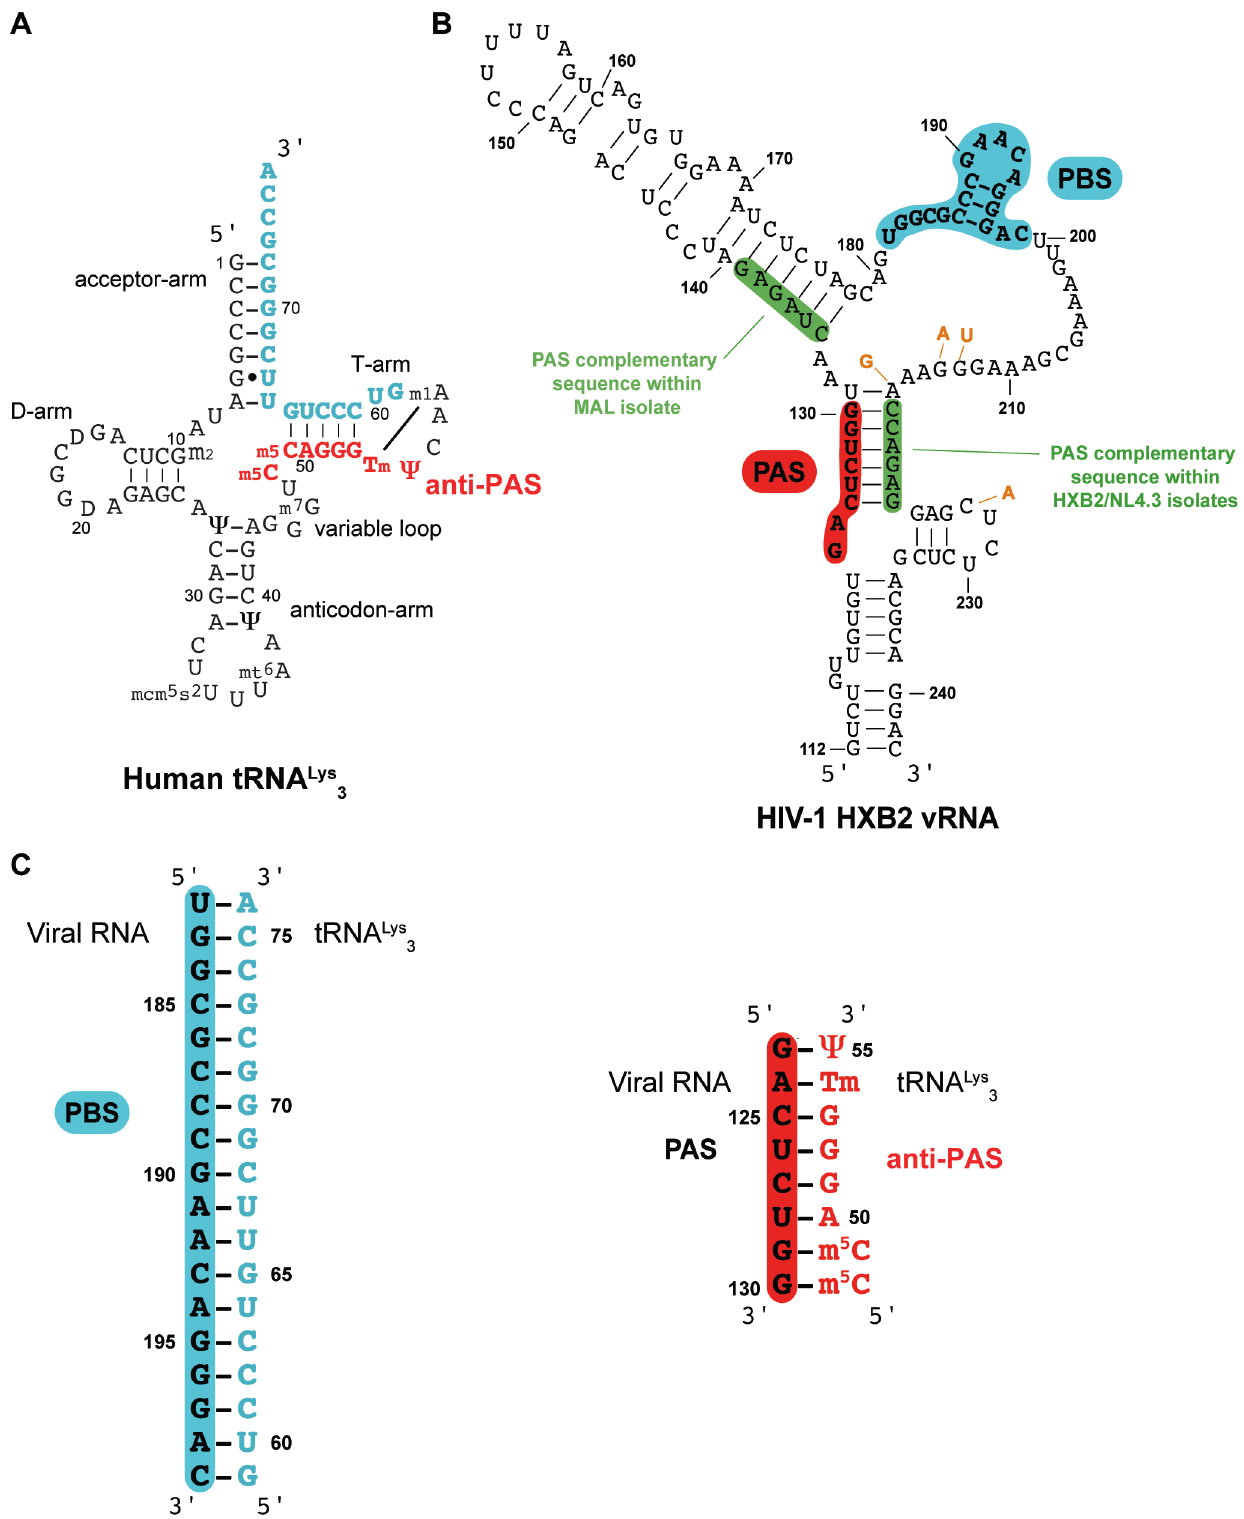
Figure 1. Secondary structure of A) the human tRNA Lys 3 , primer of the HIV-1 reverse transcription, in blue the sequence complementary to the PBS and in red the anti-PAS sequence, B) the PBS domain within the HIV-1 HXB2 isolate, in blue the PBS sequence, in red the PAS sequence and in green the sequences complementary to the PAS sequence, the nucleotides that are different between HXB2 and NL4.3 are indicated in orange, and C) the duplexes corresponding to the tRNA Lys 3 /PBS and to the tRNA Lys 3 /PAS complexes.